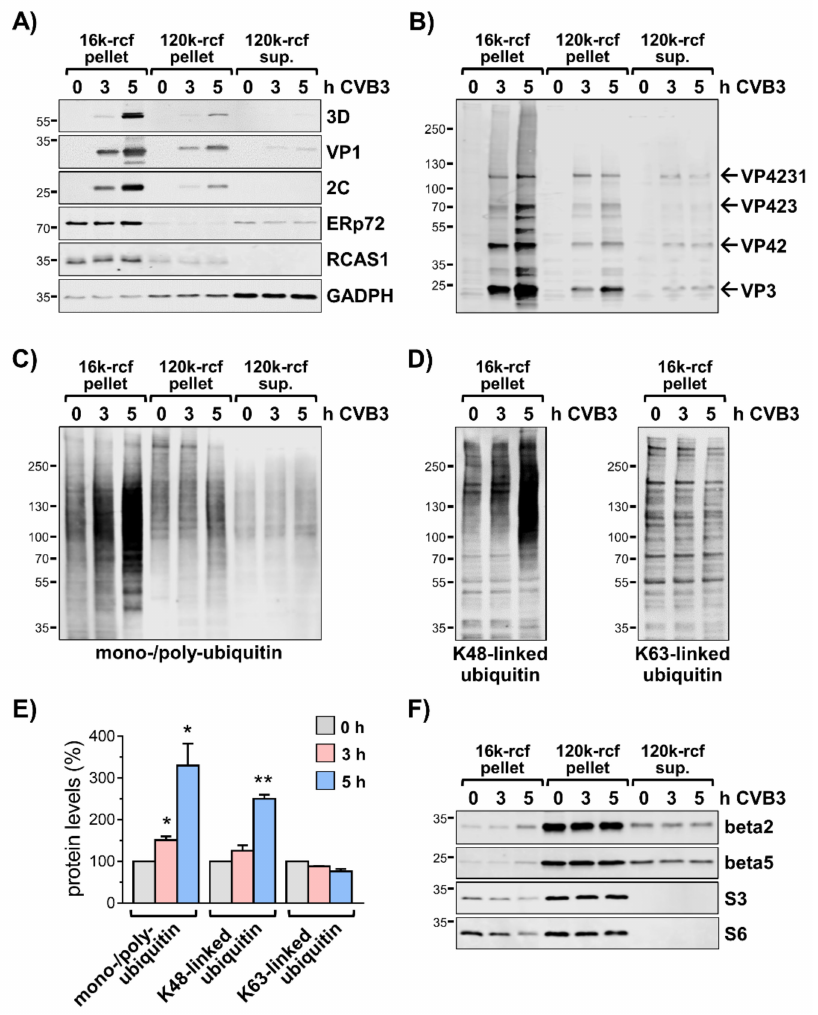
Figure 1. Accumulation of ubiquitin conjugates at CVB3-utilized compartments. ( A ) HeLa cells were treated for indicated periods of time − /+ CVB3 (MOI 1) and disrupted in hypotonic lysis buffer. Pre- cleared lysates were subjected to differential centrifugation at 16,000 rcf (16k) and 120,000 rcf (120k). Resulting membrane pellets and supernatants were analyzed by immunoblotting of CVB3 proteins 3D, VP1, and 2C, ER-marker ERp72, Golgi-marker RCAS1, and GAPDH. ( B ) Immunoblotting of fractionation samples using an antiserum raised against the fragment VP423 of the CVB3 polyprotein. The arrows indicate immunosignals of precursor proteins and cleavage products corresponding to VP4231 (~94 kDa), VP423 (~62 kDa), VP42 (~36 kDa), and VP3 (~26 kDa). ( C ) Immunoblotting of mono-/poly-ubiquitinylation in fractionation samples of CVB3 infected HeLa cells. ( D ) Immunoblots of K48-linked and K63-linked polyubiquitin in 16k-rcf membrane pellets. ( E ) The bar chart summa- rizes the densitometric analysis of anti-ubiquitin immunosignals in 16k-rcf fractions (0 h = 100%, n = 4). * p < 0.05, ** p < 0.01. ( F ) Immunoblotting of proteasomal subunits beta 2 and beta 5, and ribosomal subunits S3 and